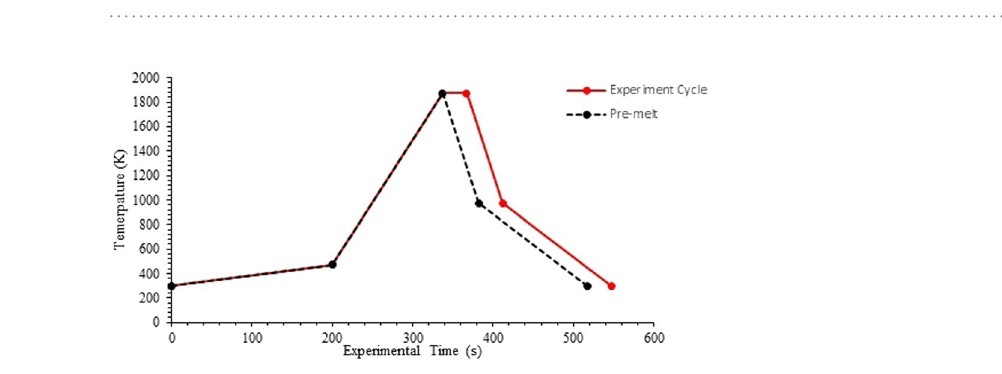
Table 2. The composition of the metal oxide mixture used for HT-CSLM experimentation after pre-melting of reagent grade hand mixed powders presented in mass %. Compositions were measured by XRF.